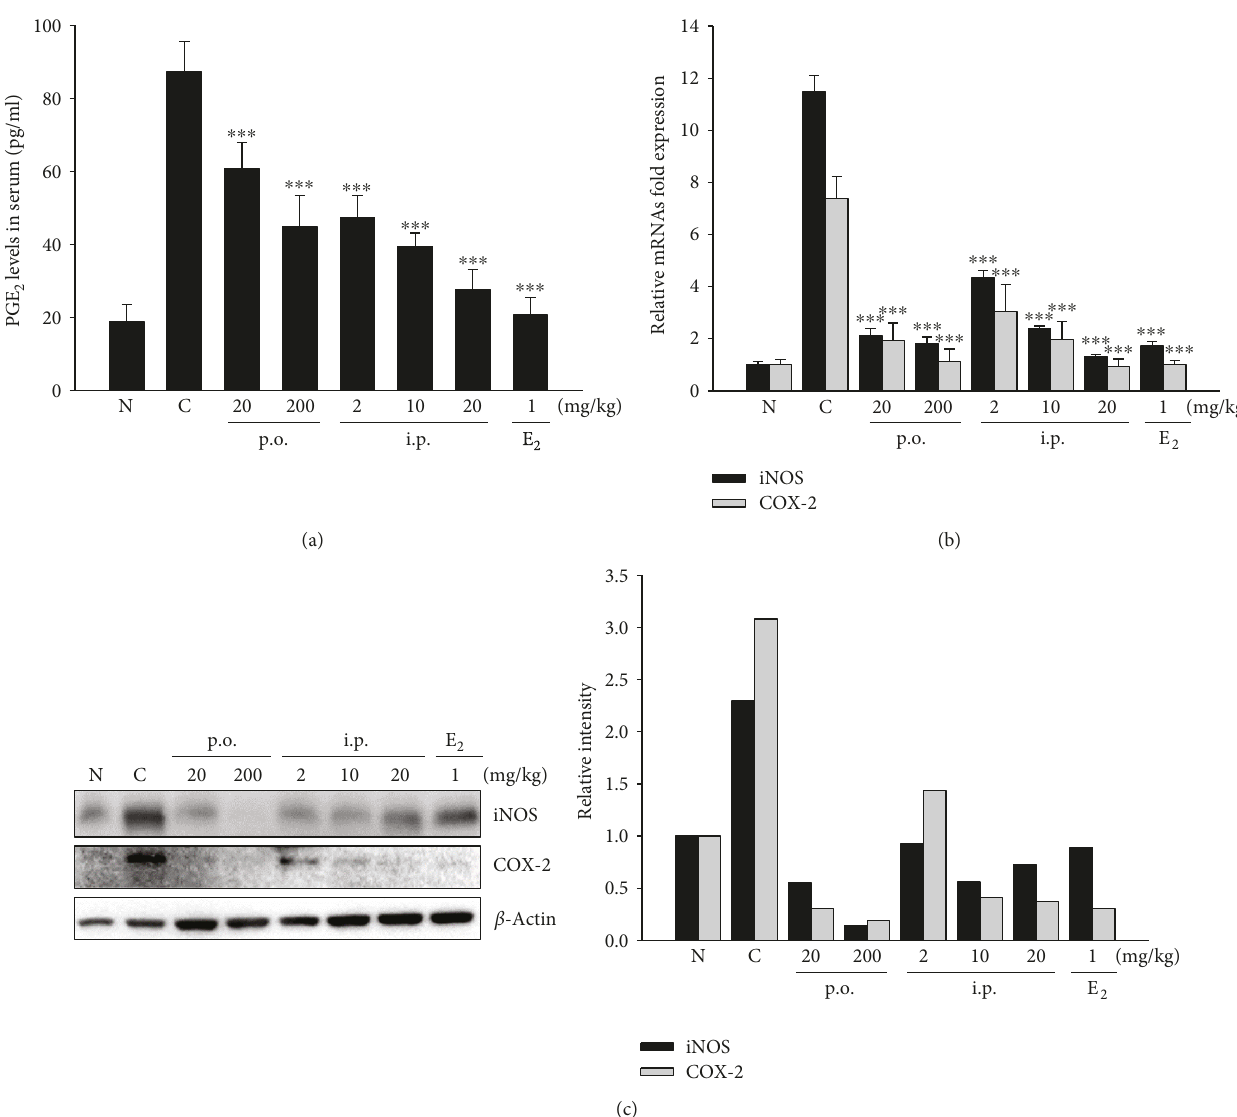
Figure 3: E ff ects of SHINBARO on in fl ammatory mediators in the LSS rat model. (a) Serum was collected from rats with LSS and was levels using an ELISA kit. The data are expressed as the mean ± SD ( n = 4 ). (b) The mRNA expression of iNOS and analyzed for PGE 2 COX-2 in the spinal cord was determined by real-time RT-PCR. The results were normalized using β -actin as an internal control. The data are expressed as the mean ± SD ( n = 4 ). (c) The protein expression of iNOS and COX-2 in spinal cord tissues was determined by western blot analysis. β -Actin was used as an internal control. Relative intensity of indicated proteins was semiquanti fi ed using the NIH ImageJ